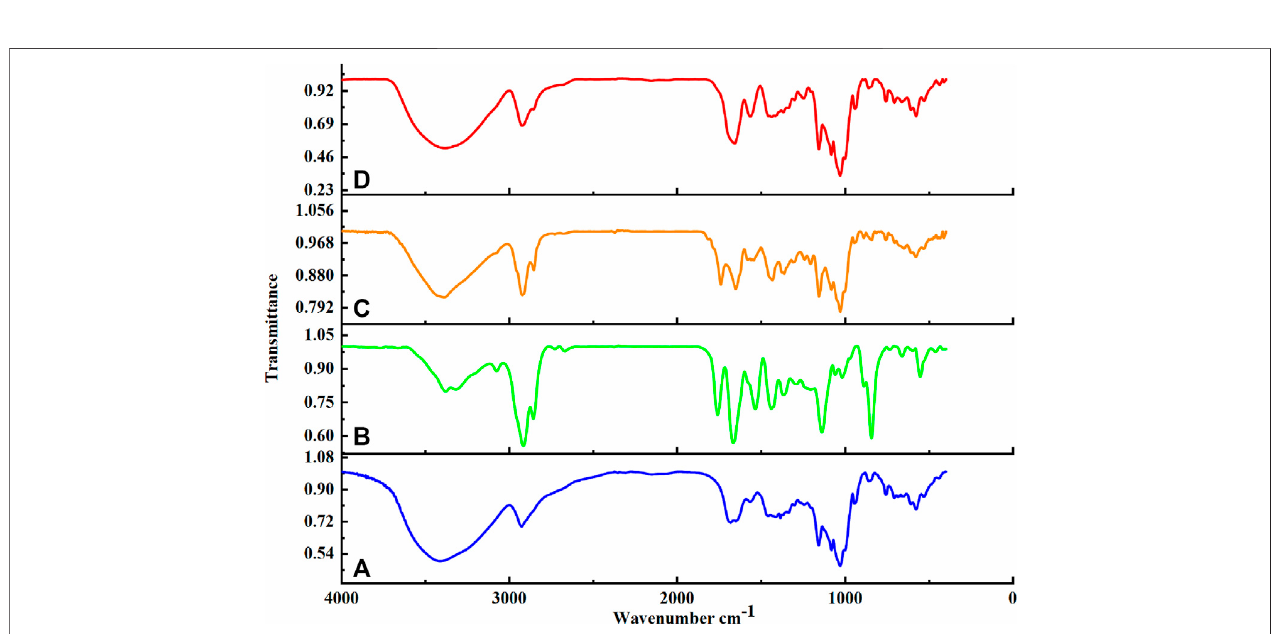
FIGURE 4 | FT-IR spectrum of (A) BIO-CD; (B) AD-CBD; (C) the physical mixture (AD-CBD: BIO-CD (cid:1) 1:1); (D) AD-CBD/BIO-CD inclusion complex.